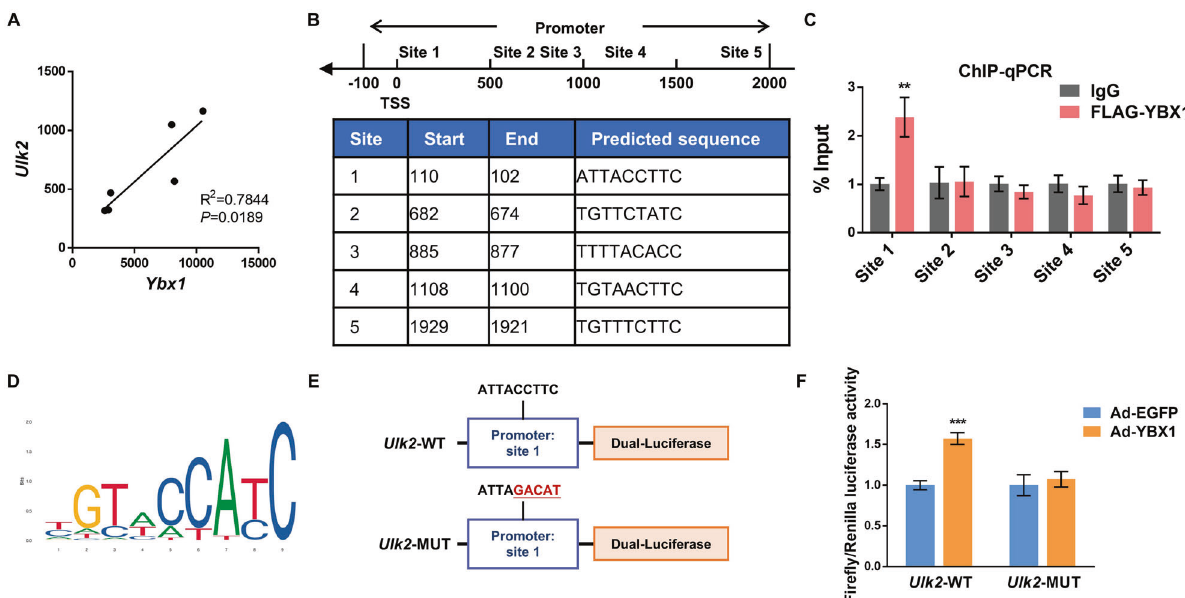
Fig. 6 Knockdown of YBX1 reduces Ulk2 expression via inhibiting its transcription. A Pearson ’ s correlation analysis of the relative expression levels of Ybx1 and Ulk2 in 3T3-L1 adipocytes by using published RNA-seq data (GSE135683) from GEO datasets. B Putative YBX1- binding site(s) within promoter of Ulk2 were predicted by using JASPAR database. TSS, transcription start site. C ChIP-qPCR analysis of the association of YBX1 with the promoter of Ulk1 and Ulk2 in 3T3-L1 cells. Nonspeci fi c IgG was used as a negative control. D Consensus YBX1 binding sites were obtained from JASPAR database. E Schematic diagram of dual-luciferase reporter constructs containing a YBX1-binding wild type ( Ulk2- WT) or mutated ( Ulk2- MUT) site within Ulk2 promoter. F Relative luciferase activity of Ulk2- WT or -MUT luciferase reporter in vector and YBX1 overexpressing cells. Fire fl y luciferase activity was measured and normalized to renilla luciferase activity. The data were presented as the mean ± SD of triplicate tests. ** P < 0.01, *** P < 0.001 compared to control